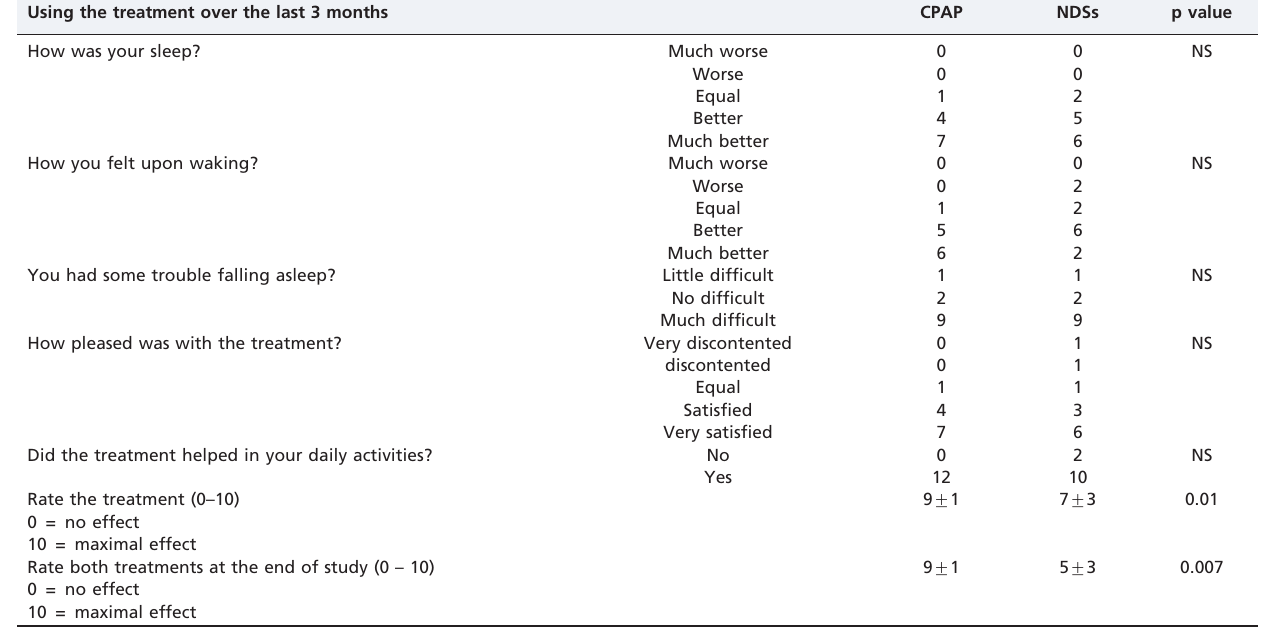
Table 4 - Satisfaction treatment questionnaire of the participants with nasal dilator strips and CPAP. Using the treatment over the last 3 months